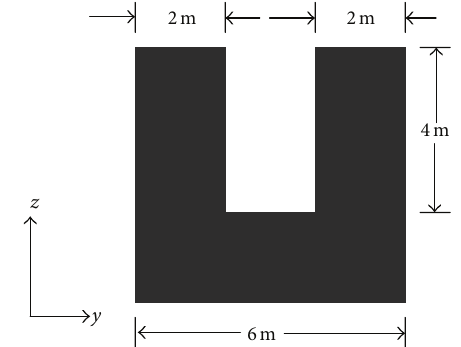
Figure 3: The cross section of a PEC object.